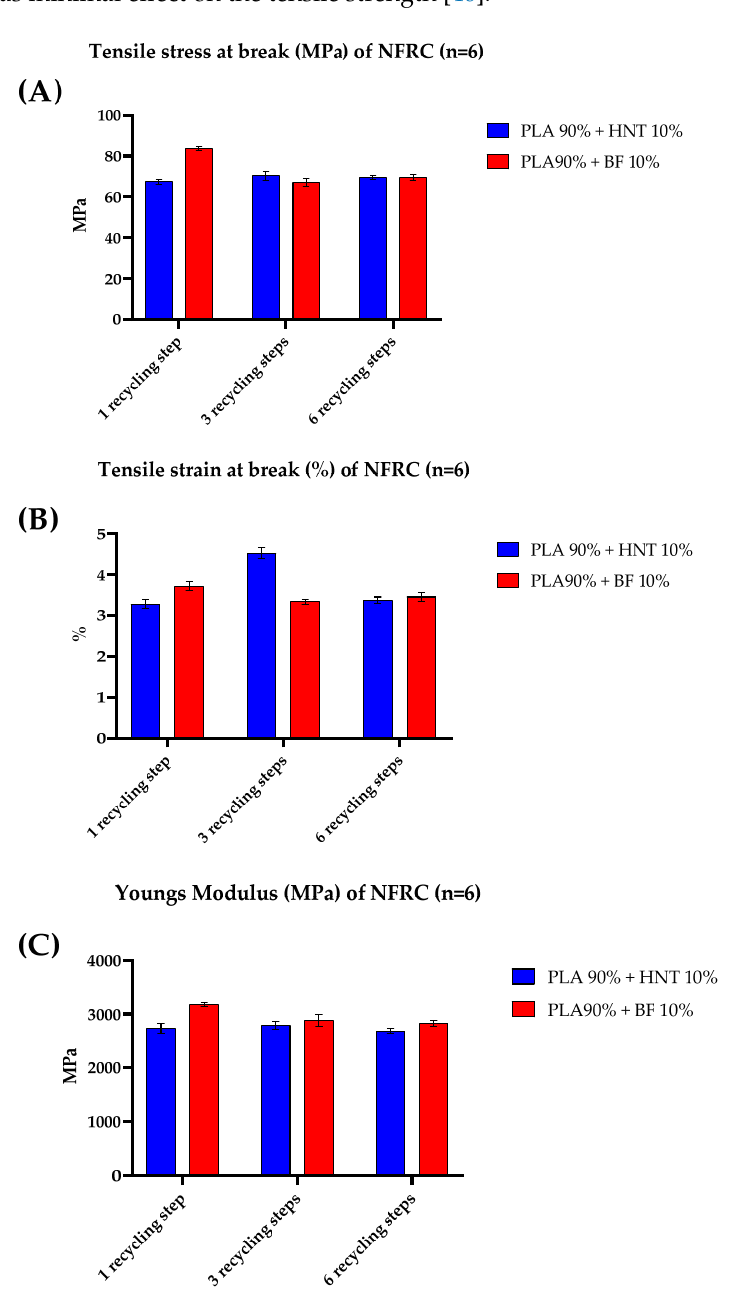
Figure 6. Values of tensile properties of all tested samples ( n = 6). ( A ) tensile stress at break of samples. ( B ) tensile strain at break of samples and ( C ) Youngs Modulus of samples; (blue) PLA 90 wt.% and HNT 10 wt.% and (red) PLA 90 wt.% and BF 10 wt.%. Error bars represent standard error of the